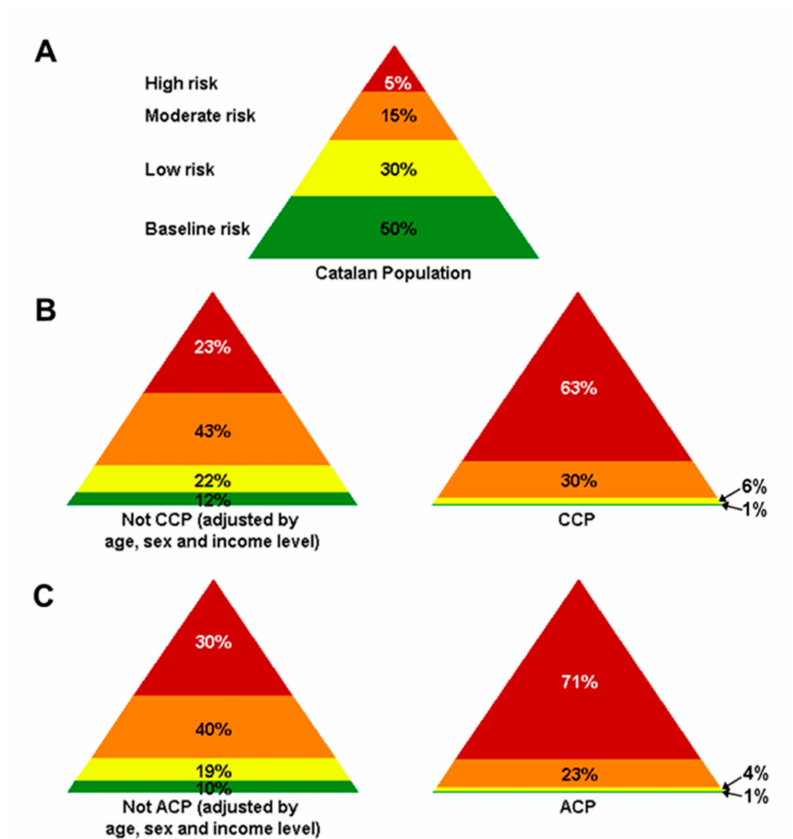
Figure 6. GMA stratification according to comorbidity risks of ( A ) total Catalan population, ( B ) CCPs, and ( C ) ACPs and their corresponding age-, sex-, and income level-adjusted non-CCP and non-ACP populations in